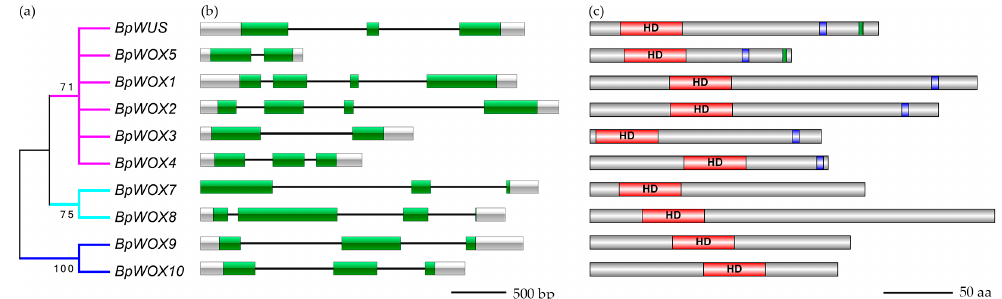
Figure 1. The schematic of BpWOX genes structure and homeodomain of BpWOX proteins. ( a ) The phylogenetic tree of BpWOX genes was reconstructed based on the multiple sequence alignment by using the neighbor-joining method in MEGA 6.0 with 1000 bootstrap replicates; ( b ) The structures of each BpWOX genes were investigated by the alignment of cDNA sequences and corresponding gDNA sequences. The untranslated regions (UTR) are colored with the gray-box, the exons colored with the green-box, and the black lines represent the introns. Bar = 500 bp; ( c ) The length of the amino acid of each BpWOX proteins was colored in gray, the homeodomain (red boxes) was across all proteins, the WUS-box (blue boxes) was only presented in the WUS clade, and the ERA domain (green boxes) were found in BpWUS and BpWOX5. Bar = 50 aa.